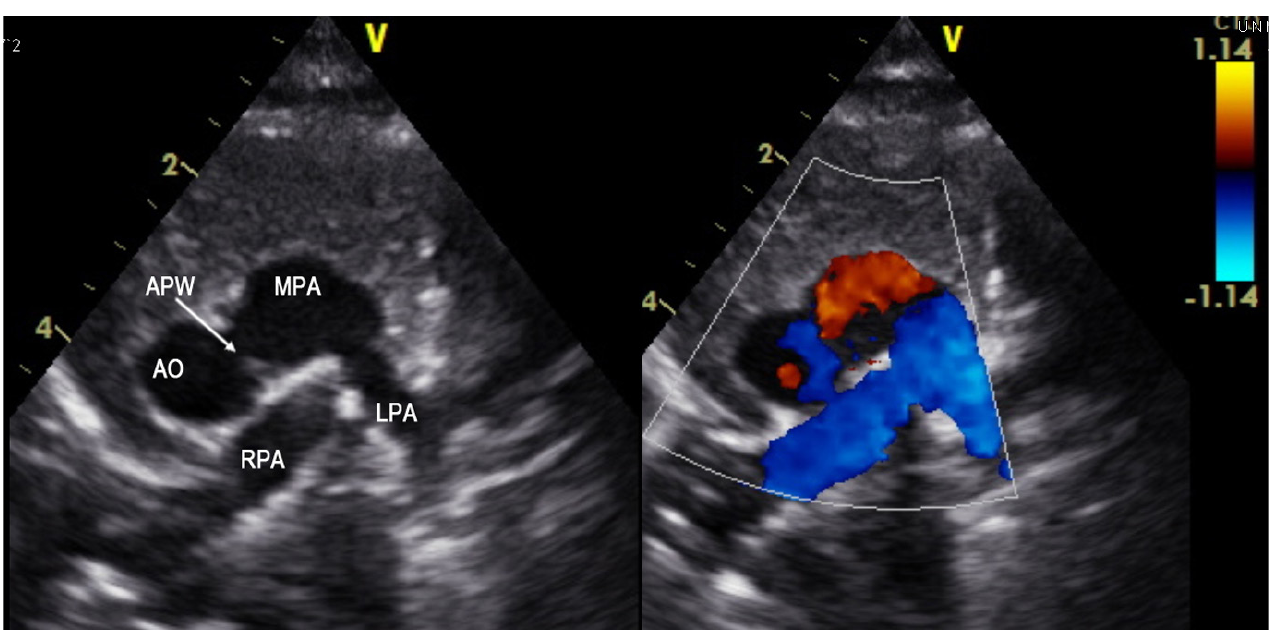
Fig. 1 – 2D echocardiography images showing distal variety of aortopulmonary window with predominant left to right